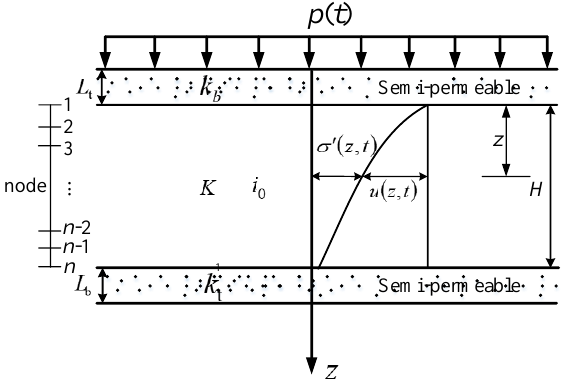
Figure 1. Sketch of 1-D consolidation with impeded boundaries.